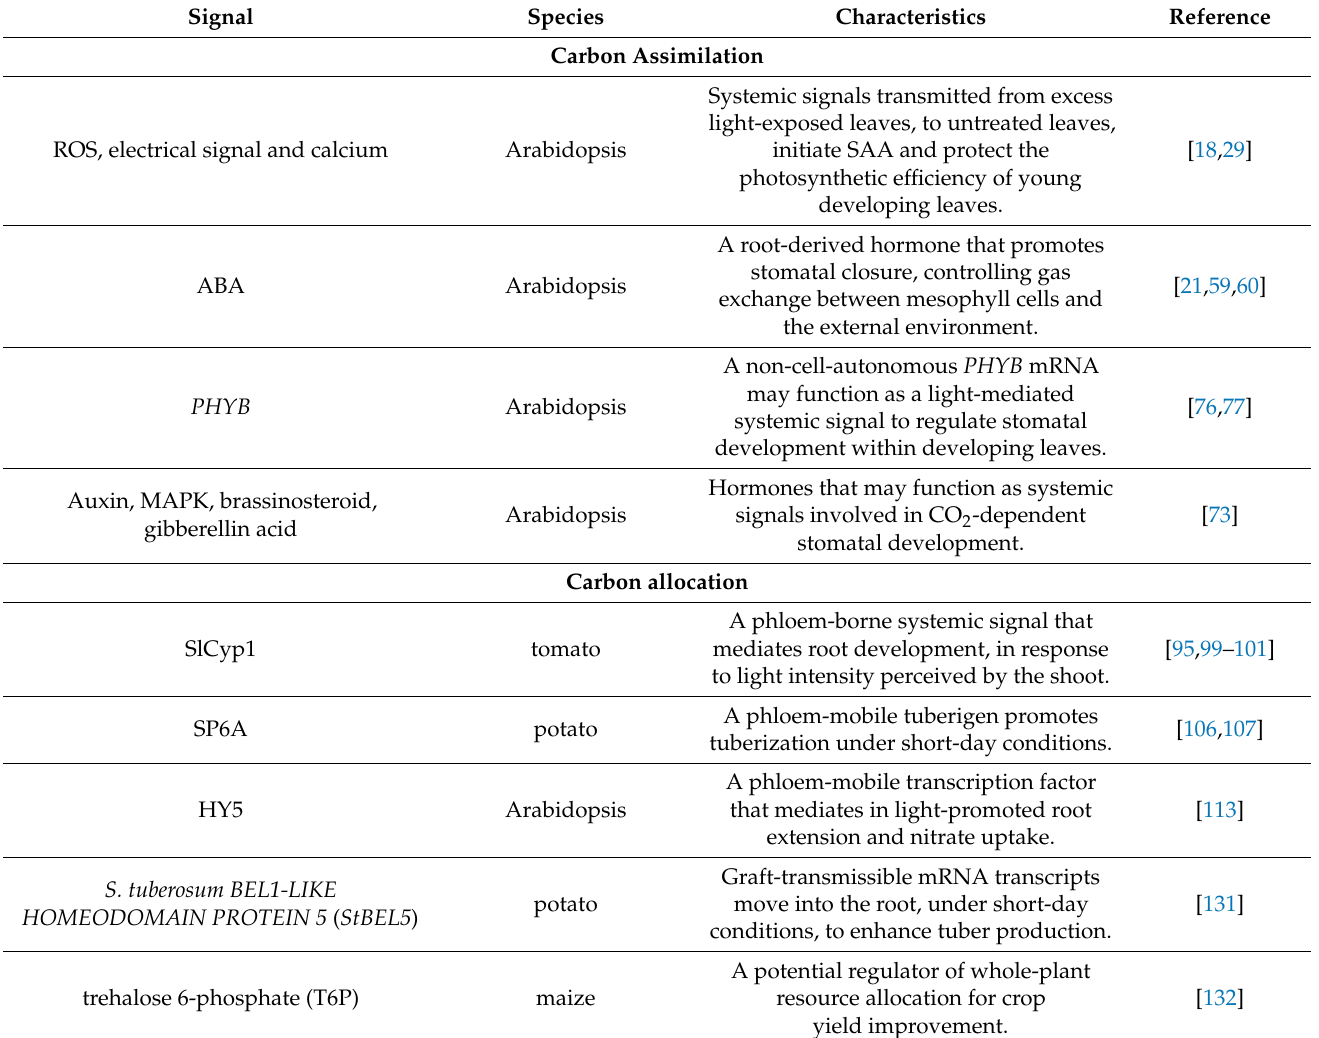
Table 1. Systemic regulatory signals involved in carbon assimilation and